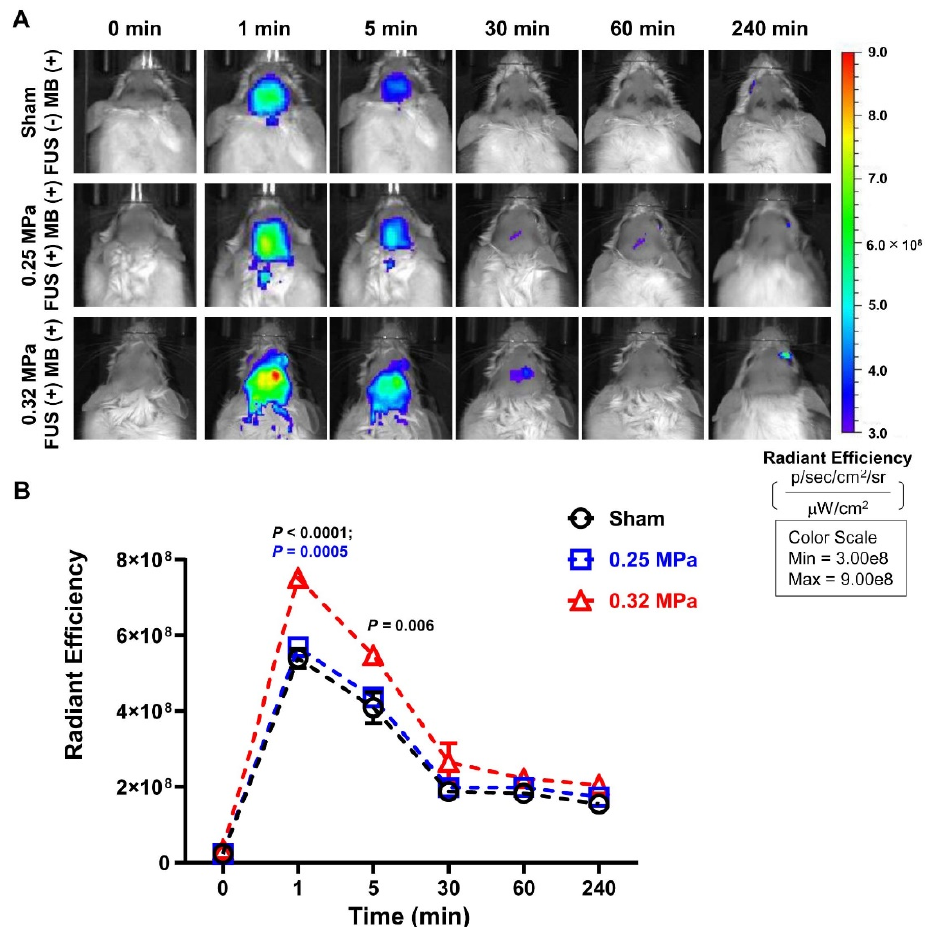
Figure 3. Detection of MB delivered to the brain using the IVIS. ( A ) Representative images of in vivo fluorescence emission were captured at fixed time points (0, 1, 5, 30, 60, and 240 min). ( B ) Radiant efficiency of fluorescence emitted from the brain post-MB injection was quantified using the IVIS (sham group: black circle; 0.25 MPa group: blue square; 0.32 MPa group: red triangle). Data are presented as mean ± SEM (N = 4 for the sham group, N = 3 for the 0.25 MPa, and N = 3 for 0.32 MPa groups). Statistical significance was analyzed using two-way ANOVA with Tukey’s multiple-comparison test.